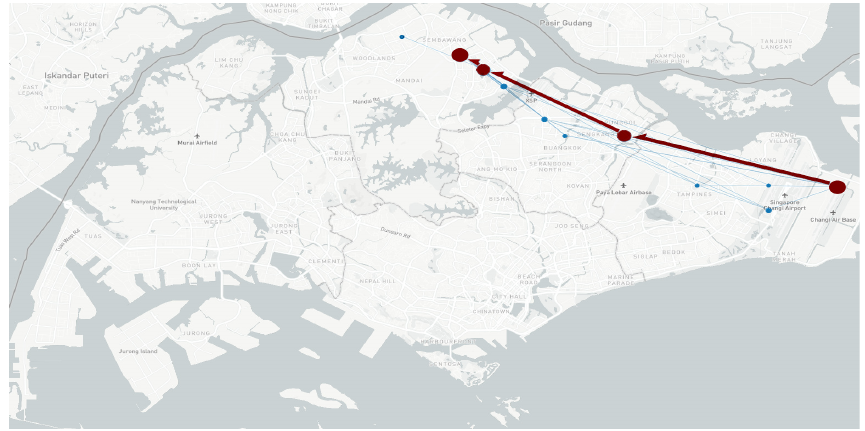
Figure 4. Example of a representative trip created from the list of anonymized trips.